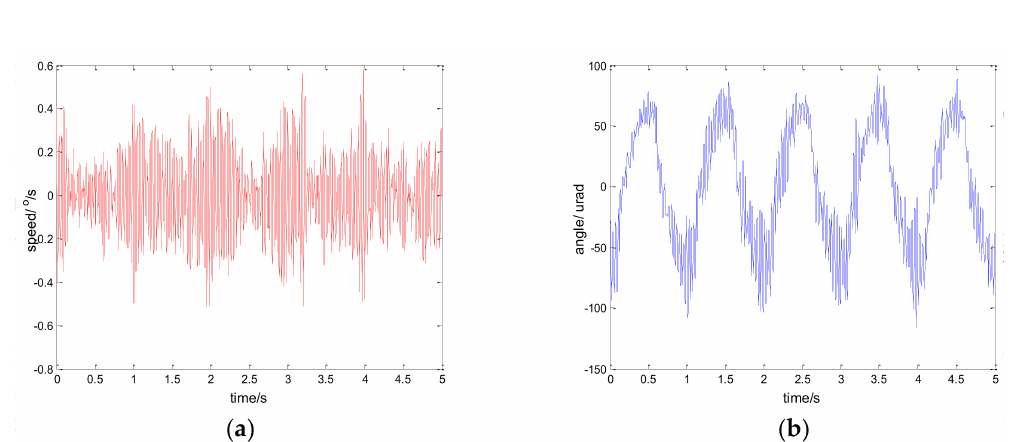
Figure 9. Experiment results of PI control. d = sin ( 2 π t ) : ( a ) speed; and ( b ) tracking error, RMS = 48.6156 urad.